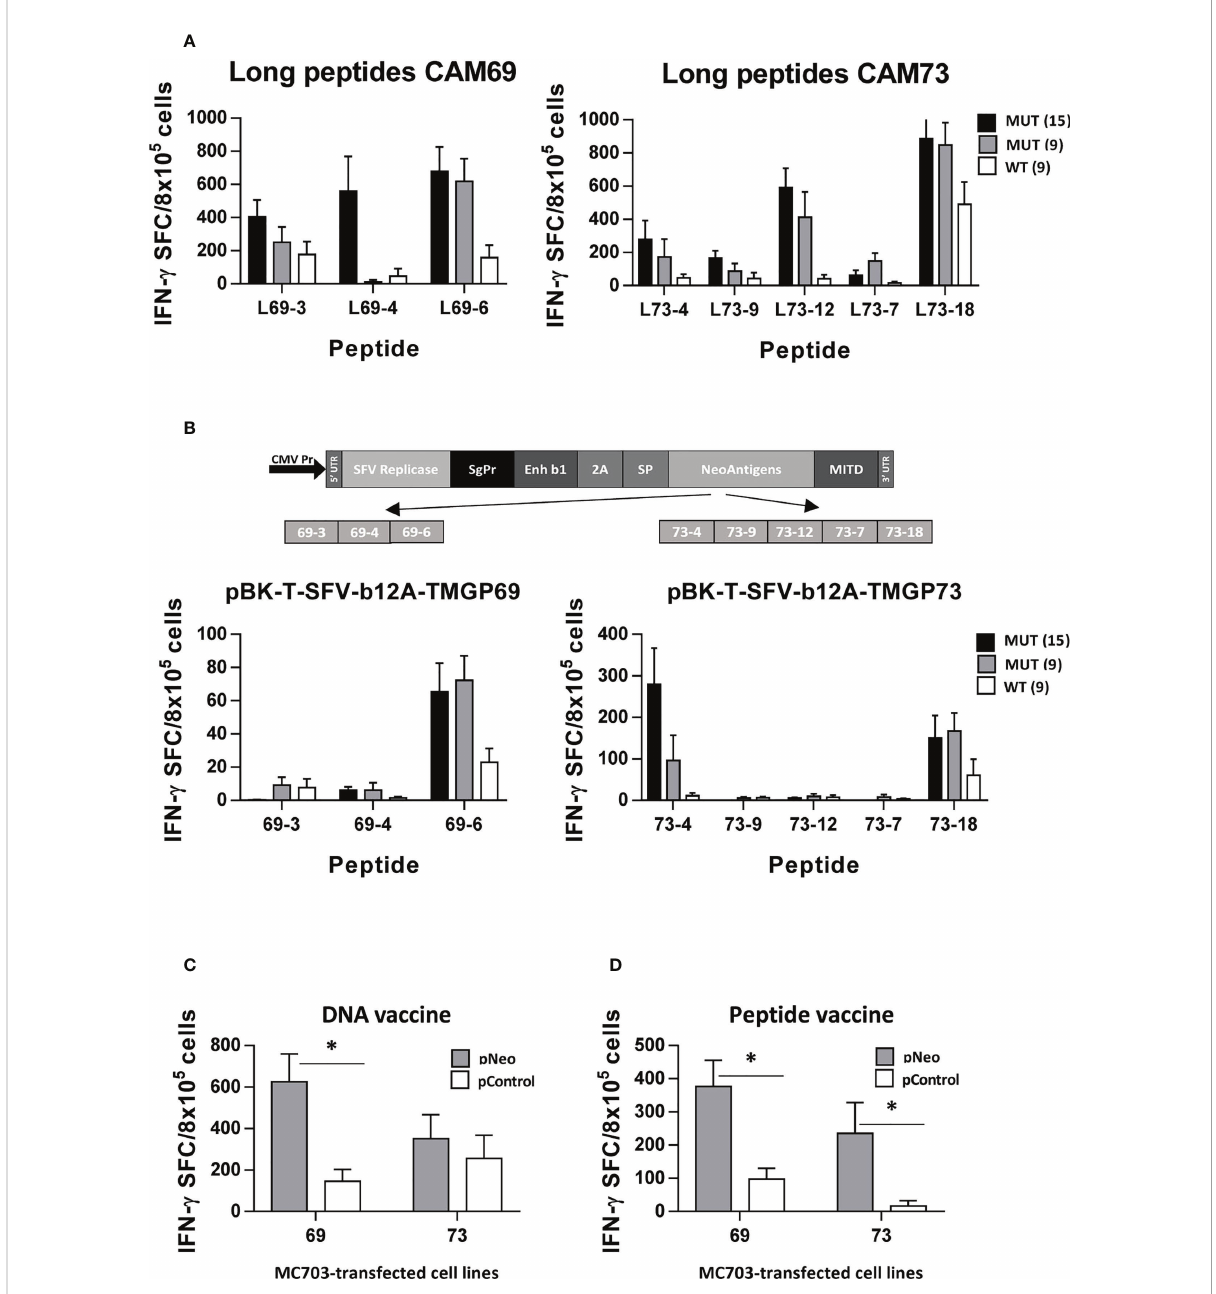
FIGURE 5 Polyepitopic vaccines induce responses recognizing neoantigen-expressing cells. HHD-DR1 mice (n=4/group) were immunized at days 0 and 7 with 15-mer peptide pools (3-5 peptides/pool) plus poly(I:C) and antiCD40 adjuvants (A) or at days 0 and 14 with a plasmid encoding the SFV replicase plus the 15-mer neoAg epitopes from patients CAM69 or CAM73 designed in tandem (B) . One week after the last immunization they were sacri fi ced and splenocytes were stimulated with MUT (15- and 9-mer) peptides or with the WT 9-mer peptides and responses were evaluated by ELISPOT. (C) Splenocytes from mice shown in B were stimulated with MC703 tumor cells transfected with a plasmid encoding the neoAgs used in the vaccine or the control Thy1.1 gene and responses were measured as above. (D) Splenocytes from HHD-DR1 mice (n=4/ group) immunized with peptides CAM69-3, CAM69-4 and CAM69-6, or peptides CAM73-4, CAM73-9, CAM73-12, CAM73-7 and CAM73-18, were stimulated as in C and responses were determined by ELISPOT. (*P<0.05; pNeo vs